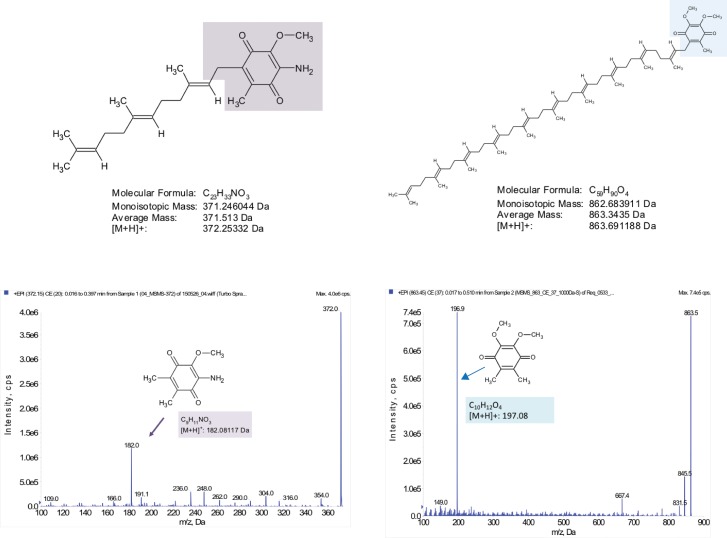
Spectra represent the elution times of detection of the rhodoquinone head group (182.1 m/z; left) and ubiquinone head group (197.1 m/z) following fragmentation of parent ions of different isoprenyl chain lengths as indicated.